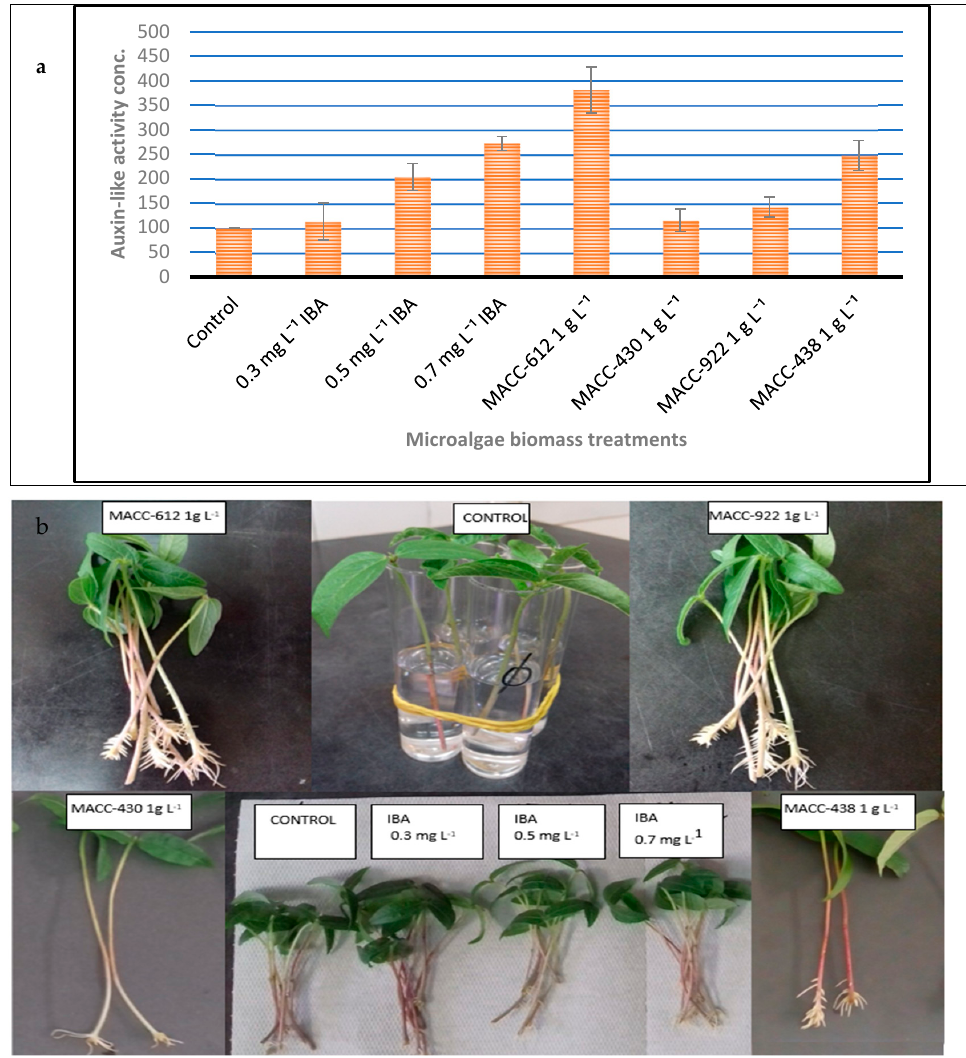
Figure 2. ( a ) Mungbean hormonal activity bioassay for 4 selected microalgae strains, compared with the physiological effect of different concentrations of IBA. Number of rootlets calculated as concentrations of auxin-like substance under the influence of auxin-like hormone present in the treatments. ( b ) An image of mungbean bioassay with IBA (indole butyric acid) as a positive control to compare with the 4 microalgae strains biomass. Table 2. Determination of indole-3-acetic-acid (IAA), salicylic acid (SA), p-hydroxybenzoic acid (pHBA), benzoic acid (BA), and t-cinnamic acid (tCA) from freeze-dried algae biomass samples using an Acquity I/Class UPLC system - Xevo TQ/XS tandem mass spectrometer. Data represent mean ng g − 1 DW ± SD; n = 3. n.d.: not determined, under the detection limit. Different letters indicate significant differences at p <